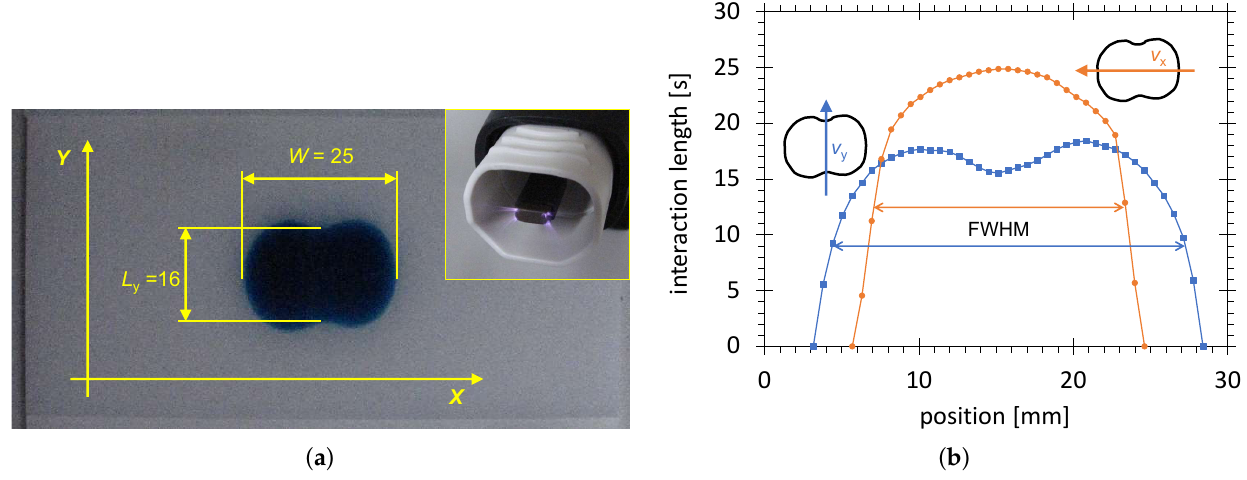
Figure 5. The activated zone produced on a HDPE substrate by CeraPlas™F module operated 10 s with the power of 8 W. ( a ) The image achieved statically by use of 58 mJ/m 2 test ink. ( b ) The interaction length of the activation zone with the single point of the substrate for movement of the substrate along the x and y axis of the ink image. The arrows show the movement direction with respect to the activation image. The point position is defined on the axis perpendicular to the movement direction. For both curves, the full widths at half maximum (FWHM) is